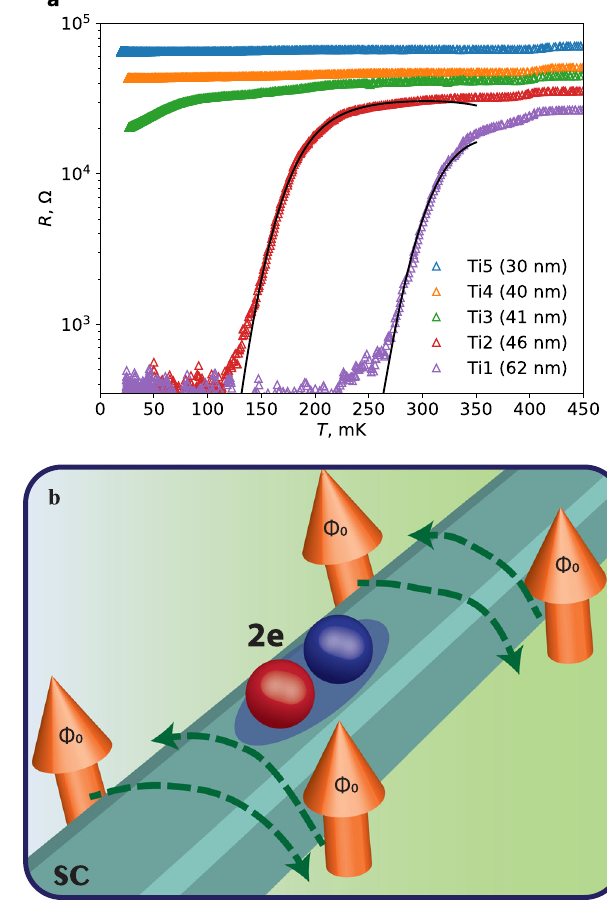
Fig. 3 Resistance data and localization of Cooper pairs. a Resistance versus temperature R ( T ) measured for fi ve Ti nanowires of length L = 20 μ m, thickness d ≃ 35nm, and nominal width values w indicated in brackets for each of the samples. Solid lines represent fi ts of the data for samples Ti1 and Ti2 to the theory 9 within its validity range. Resistance saturation observed in these two samples at low T is due to fi nite voltage sensitivity of about few nV corresponding to residual resistance ~100 Ω measured using ac bias current ~10 pA rms. Error bars are smaller than data points. b Localization of Cooper pairs (with charge 2 e ) generated by quantum tunneling of magnetic fl uxons Φ 0 across the nanowire. This phenomenon explains the low-temperature behavior of R ( T ) observed in samples Ti3, Ti4,